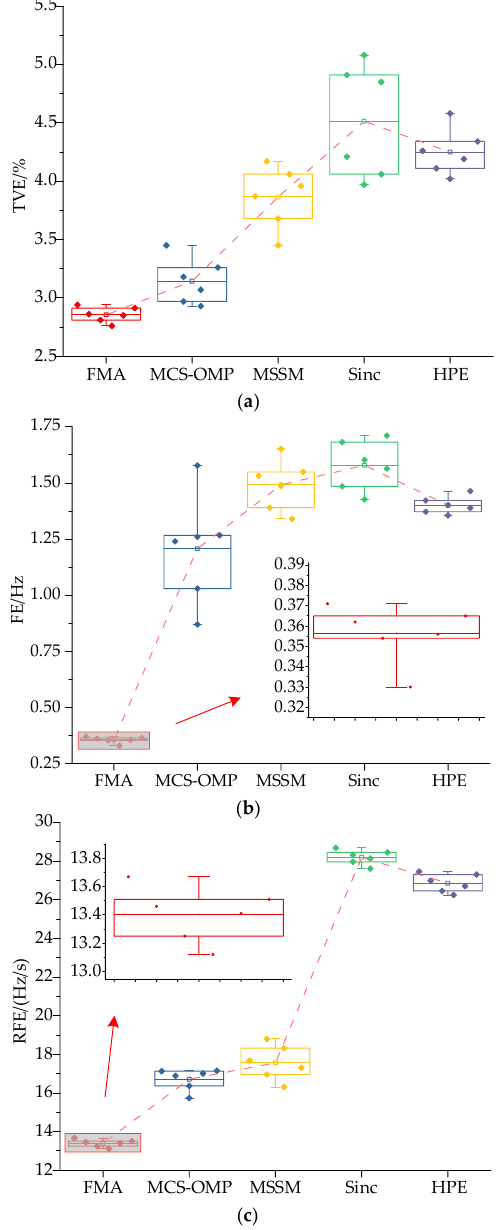
Figure 6. High-frequency harmonic modulation test results: ( a ) TVE values for each algorithm; ( b ) FE values for each algorithm; ( c ) RFE values for each algorithm.